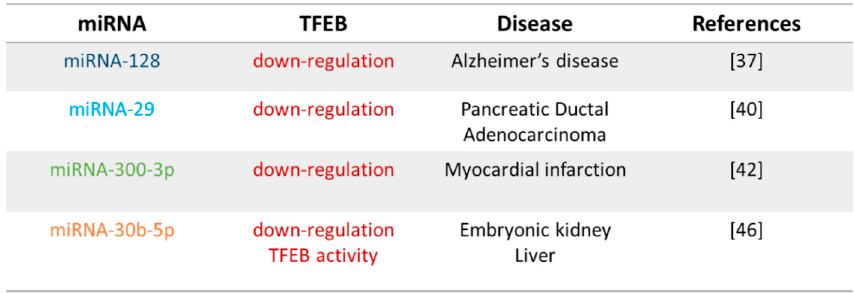
Figure 4. Post-transcriptional regulation of TFEB by miRNA and correlated